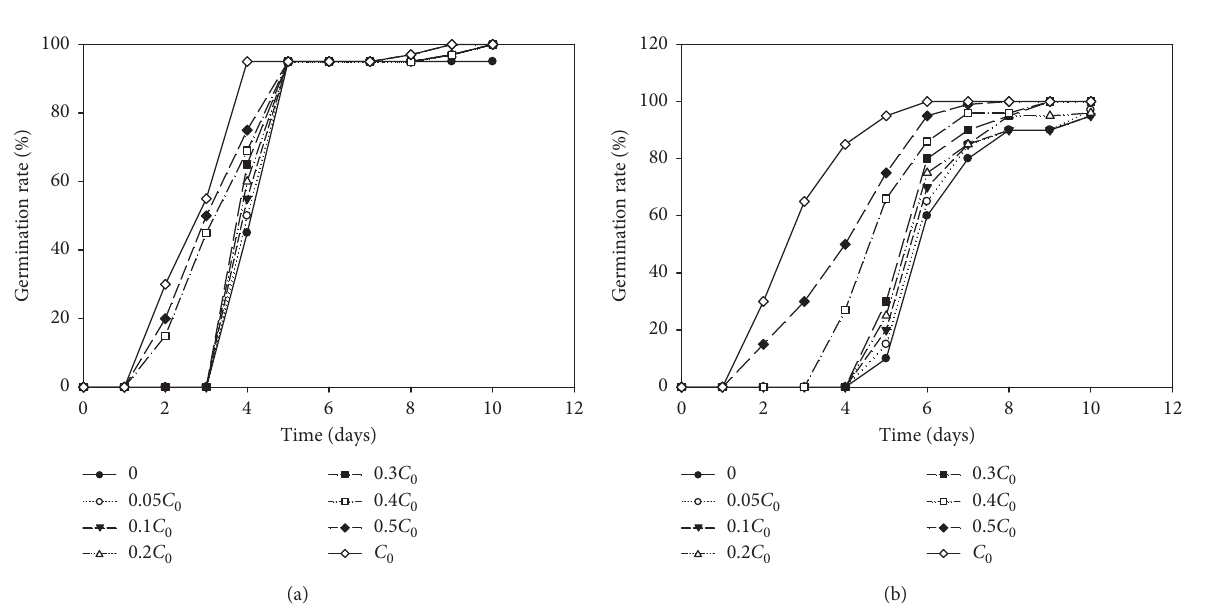
Table S1: response characteristics of the phytohormone standards using HPLC-ESI-MS/MS. Table S2: linear re- gression data for fourteen phytohormones ( n = 6). Figure S1: structure of the fourteen plant hormones. Figure S2: spectra